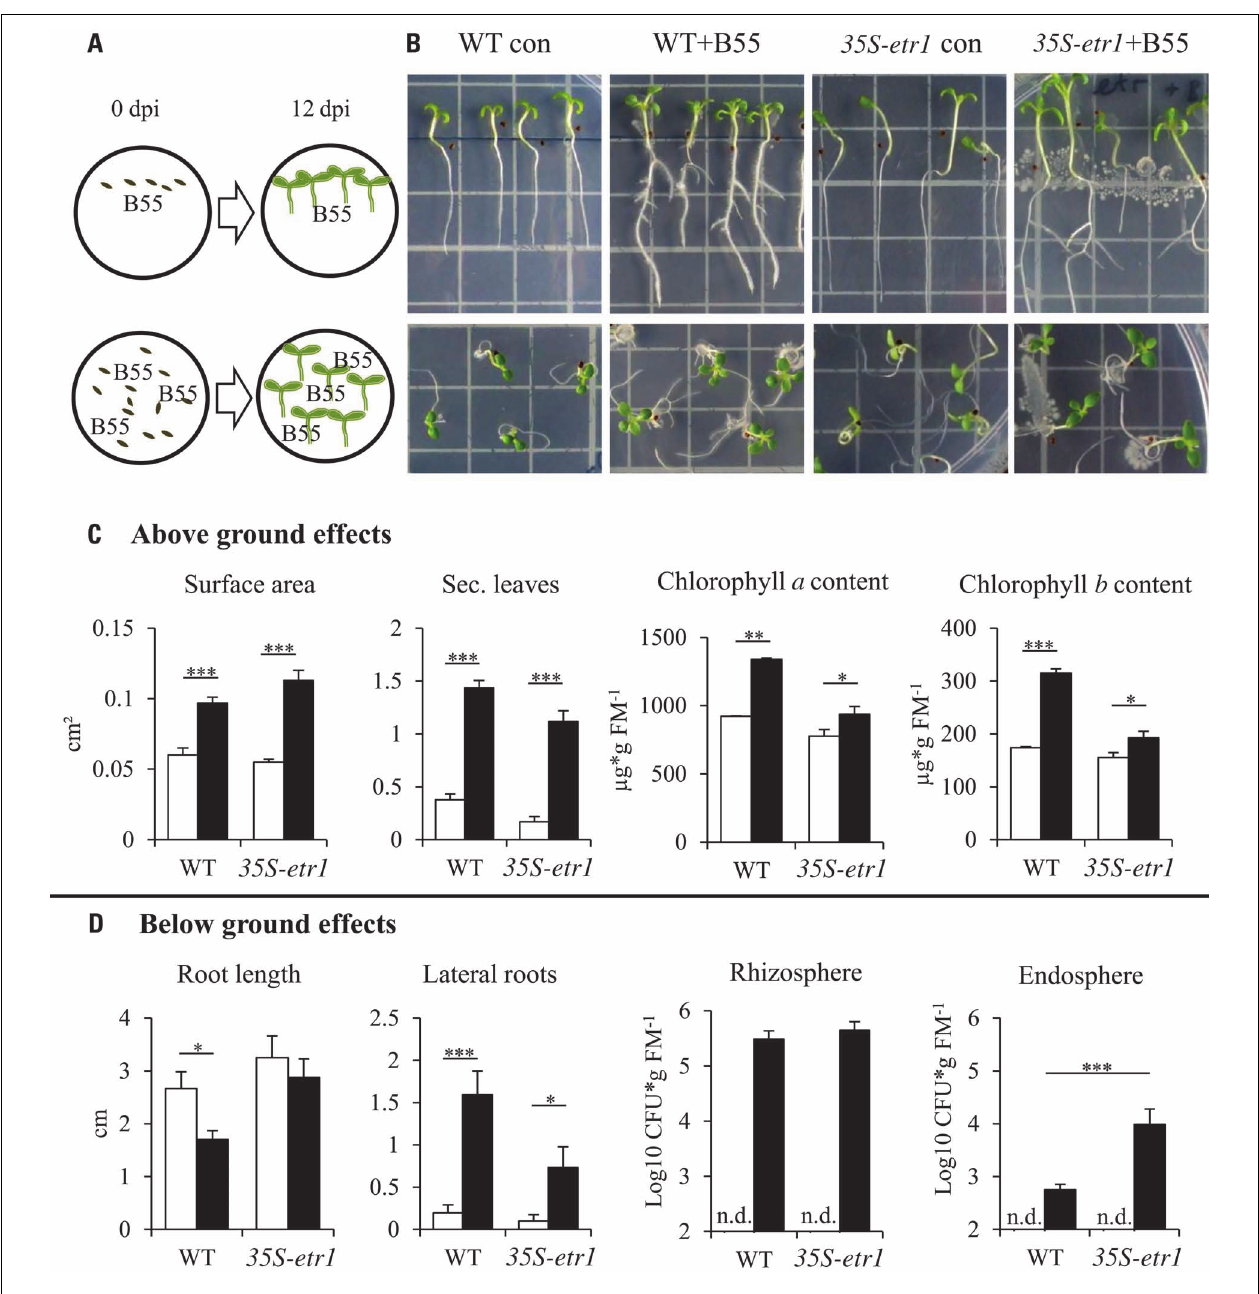
White bars represent control treatments, black bars, B55-inoculated seeds (PLSD test of an ANOVA between mock- and B55-inoculated plants: * P < 0.05; ** P < 0.01; *** P < 0.001). CFU, colony forming unit; FM, fresh mass; n.d., not detected. n = 4 replicate Petri dishes containing at least 20 or 7 seeds (vertical placement), n = 5 replicate Petri dishes containing at least 20 seeds (for